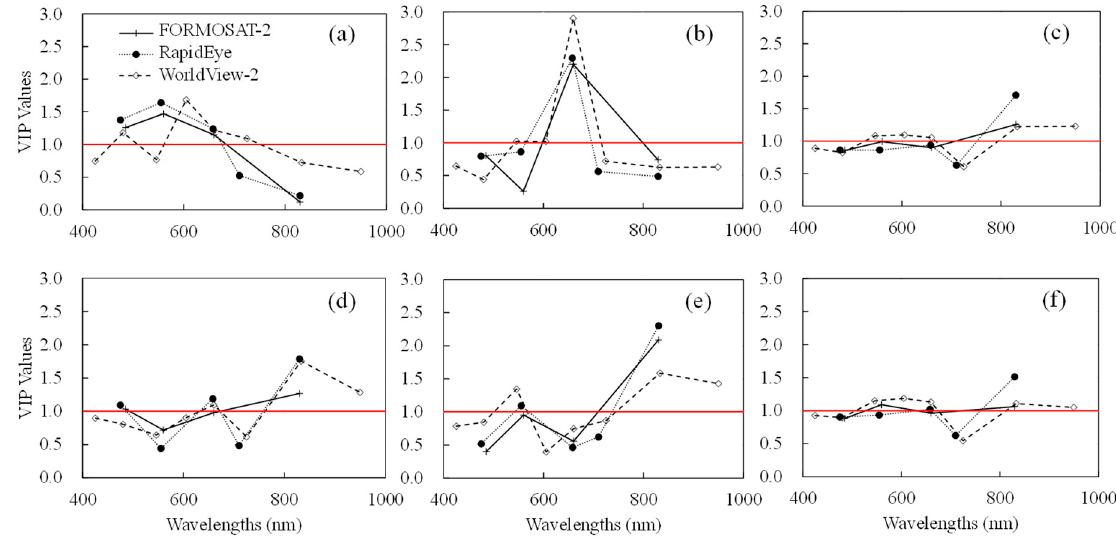
Figure 6. Variable Importance in Projection (VIP) values as function of wavelengths formatted to FORMOSAT-2, RapidEye, and WorldView-2 spectra for plant N concentration (PNC) estimation at: the panicle initiation (PI) ( a ); stem elongation (SE) ( b ); and heading (HE) ( c ) stages; and for N nutrition index (NNI) estimation at: the PI ( d ); SE ( e ); and HE ( f ) stages.